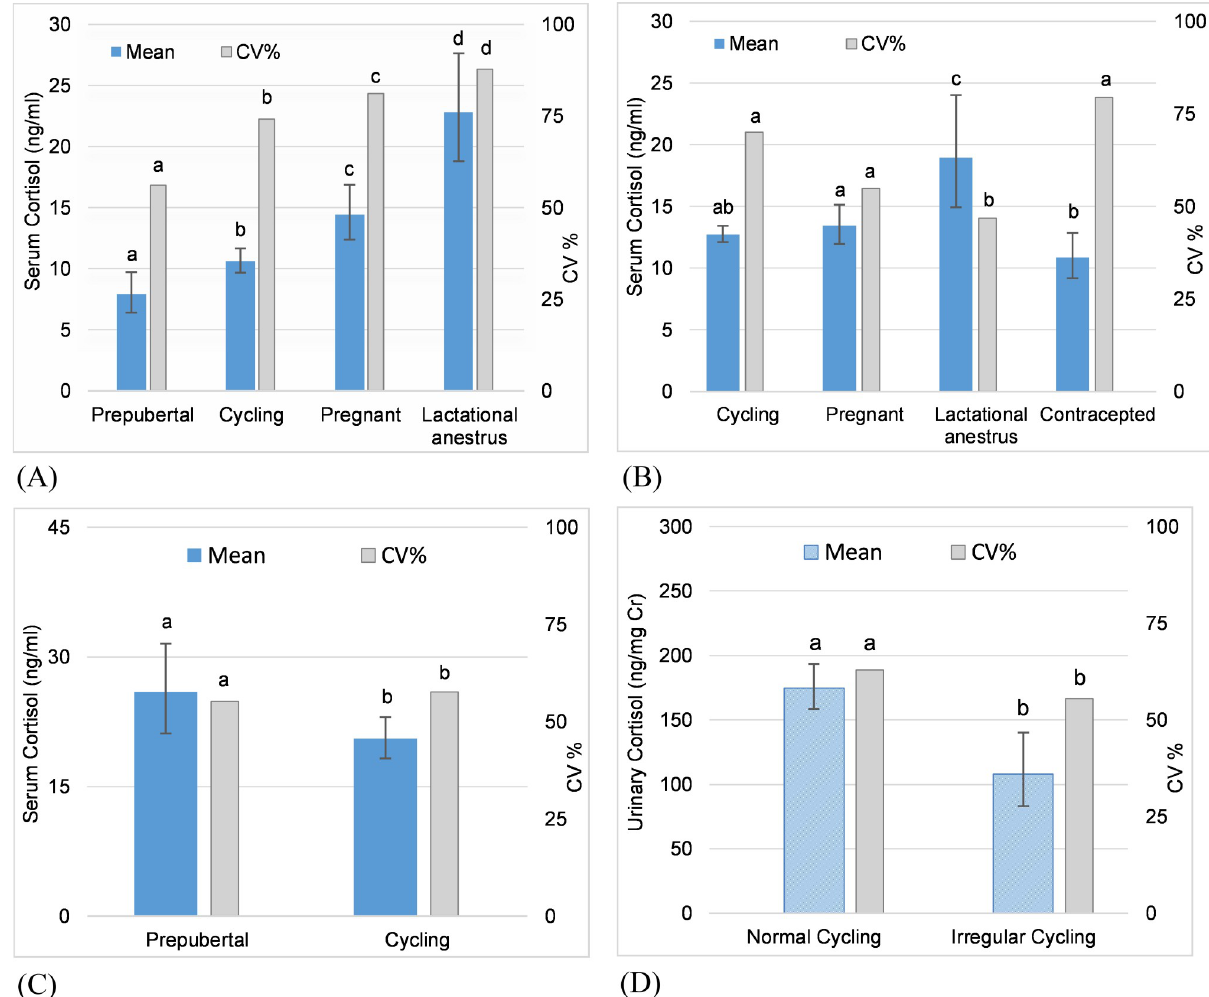
Fig 1. Reproductive state as a predictor of adrenal GC activity. Predictions from GLMMs for serum and urinary cortisol concentration comparing mean values across reproductive states (error bars represent the standard error of the prediction). Letters denote significant differences in mean values and in coefficients of variation (CVs) across reproductive states. (A) F1OZ: mean cortisol in prepubertal < cycling < pregnant < lactational anestrus. (B) F5NZ: mean cortisol in cycling, pregnant, contracepted < lactational anestrus. (C) F2OZ: mean cortisol in cycling < prepubertal. (D) F9NZ: mean cortisol in irregular cycling < normal